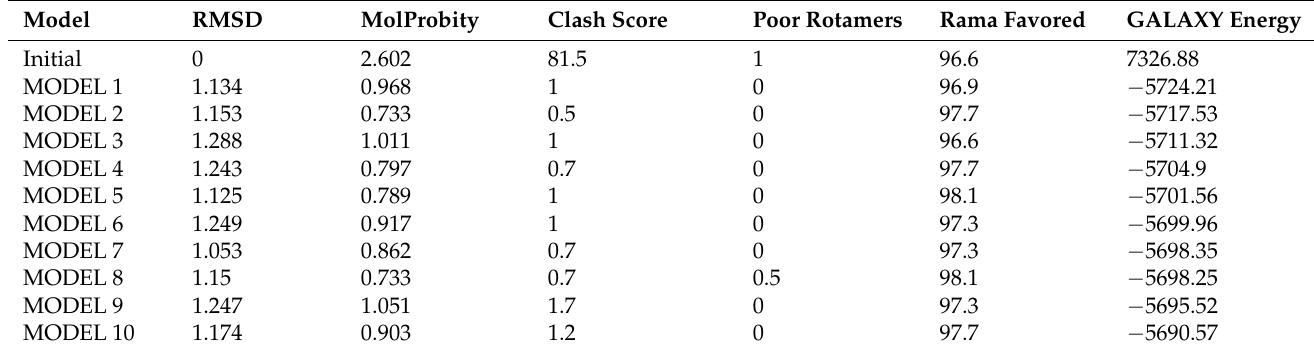
Table 2. Description of refined MEV models generated by GalaxyRefine2.